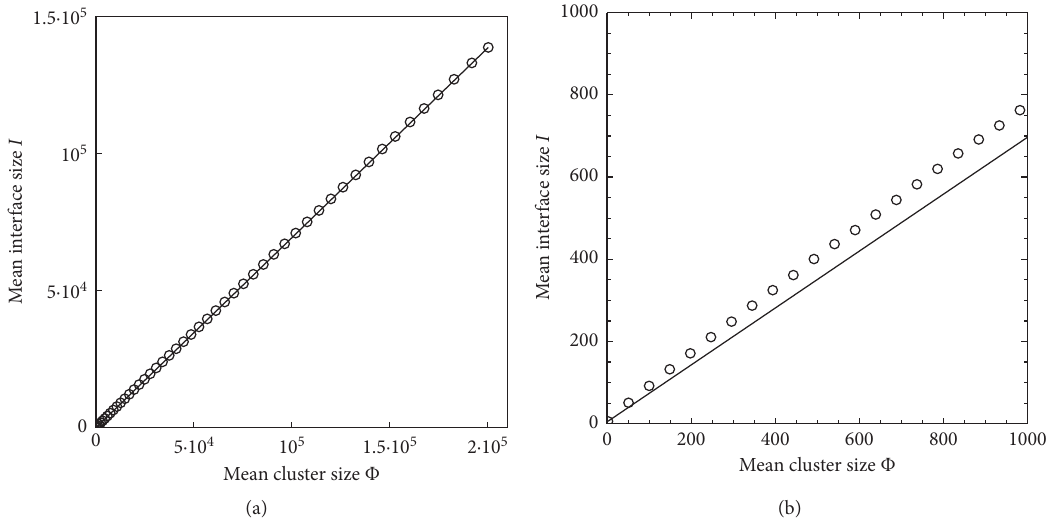
Figure 2: The mean interface size I of percolation clusters for different cluster size intervals (circles). The thin line connects the first ( Φ ,I ) � ( 1 , 4 ) , which is the data point corresponding to a single-site cluster, and the last available data point to highlight the nonlinear relation between I and Φ